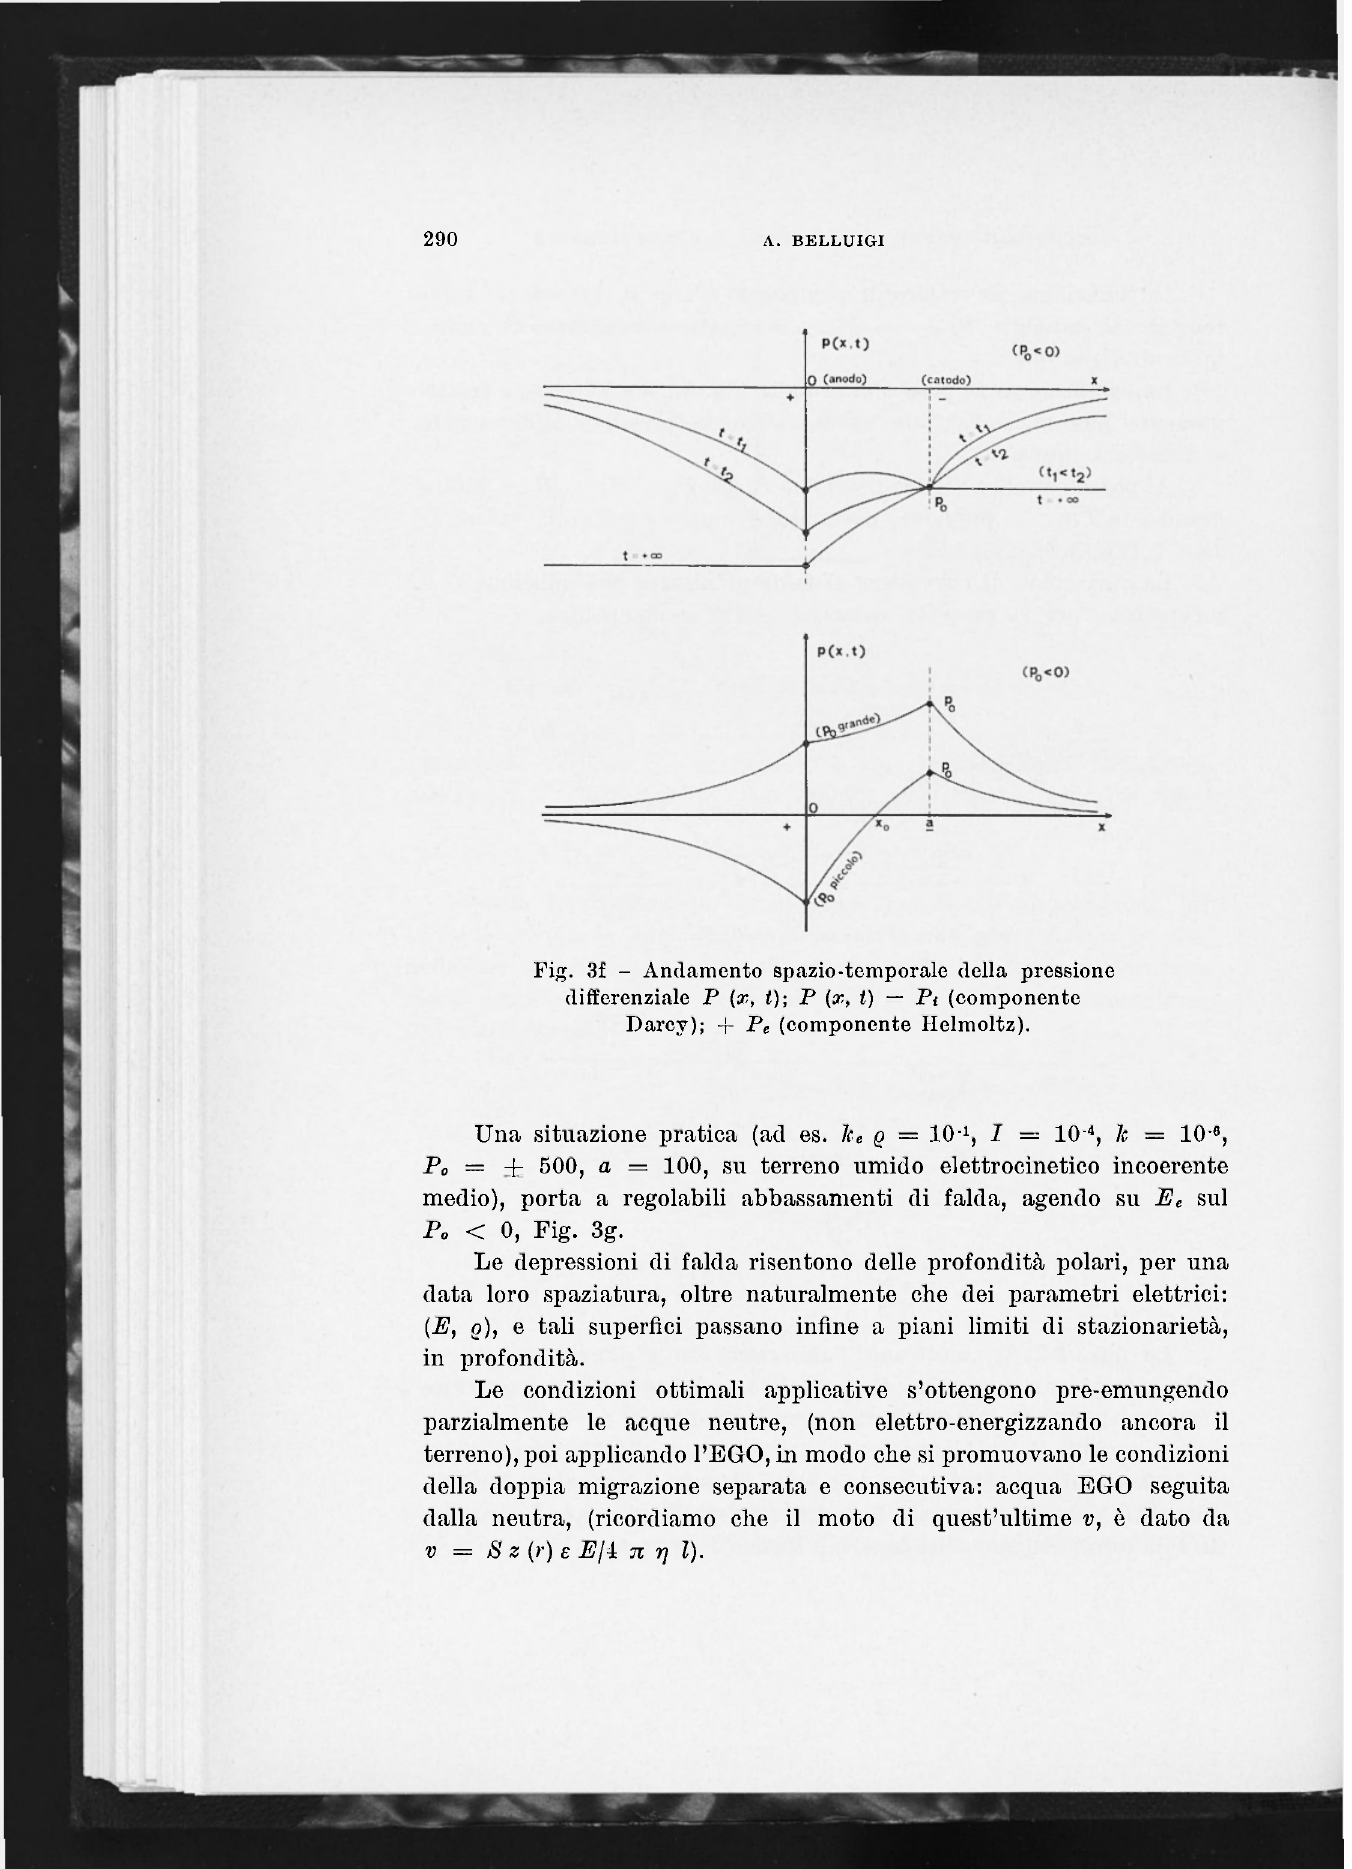
Fig. 3f - Andamento spazio-temporale della pressione differenziale P (x, t); P (x, t) — Pi (componente Darcy); + P e (componente